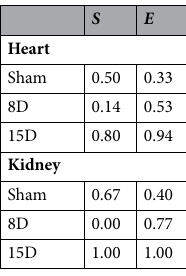
Table 2. Sensibility (S) and Specificity (E) for groups discrimination in heart and kidney samples based on PLS-DA